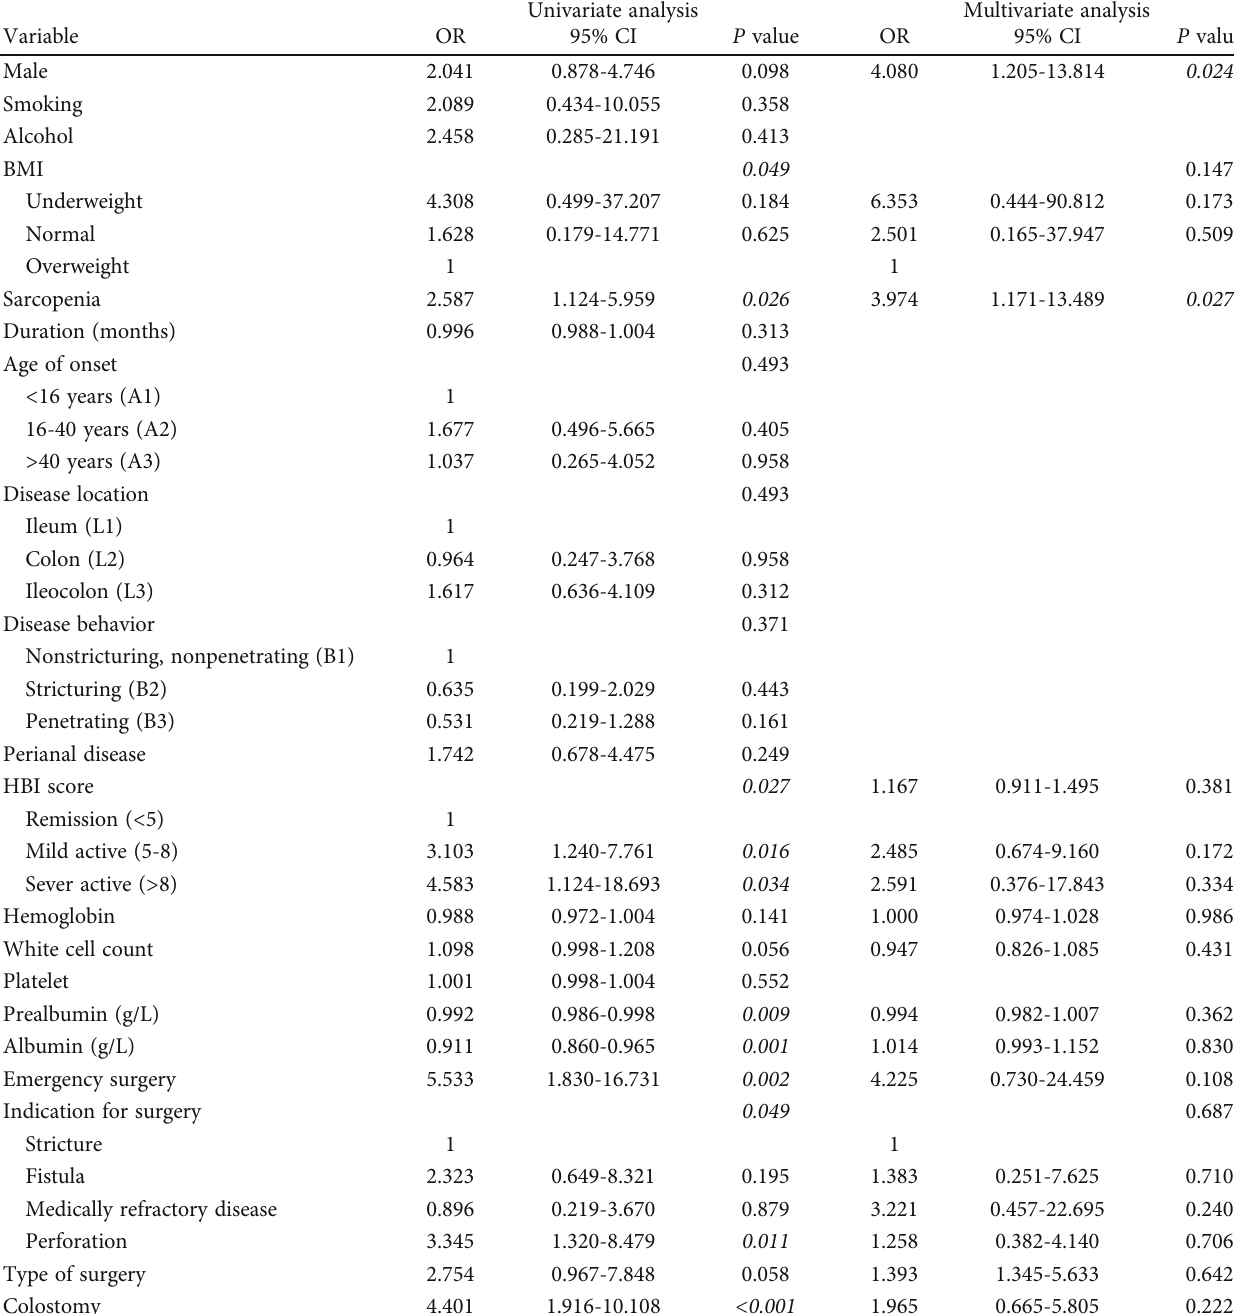
Table 4: Univariate and multivariate regression analysis for risk factors of postoperative